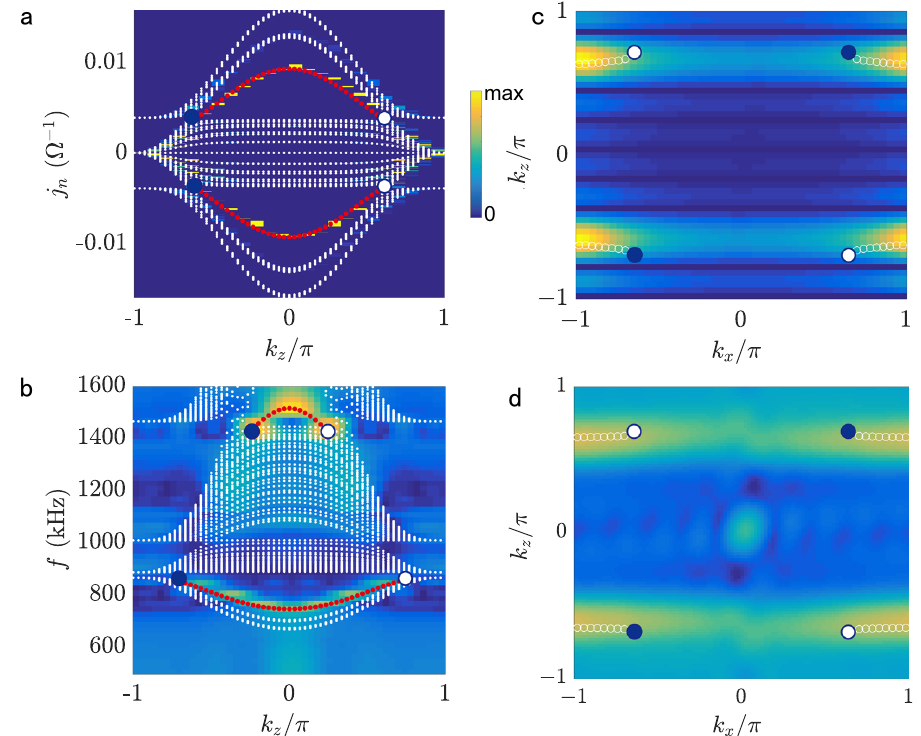
j n =0.004082 Ω − 1 , connecting the projections of the Weyl points on k x - k z surface. d “ Fermi arc ” of the surface states at 835kHz. The color map and the white circles represent the experimental and theoretical results, respectively.